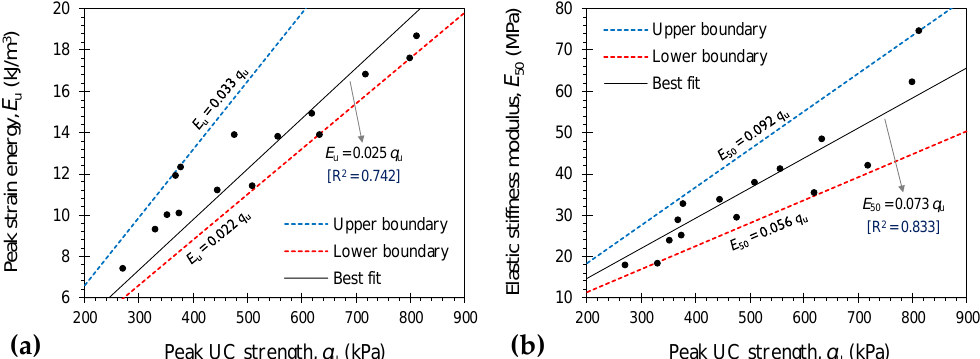
Figure 3. Variations of ( a ) peak strain energy E u and ( b ) elastic stiffness modulus E 50 against peak UC strength q u for various MC-treated mixtures (i.e., M x F y T z where x = {1.5, 2.5, 3.0}, y = {0} and z = {7, 14, 28, 56, 128}).